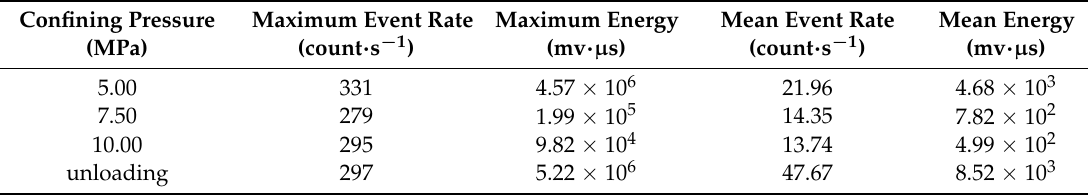
Table 2. AE results of specimens under different stress condition.